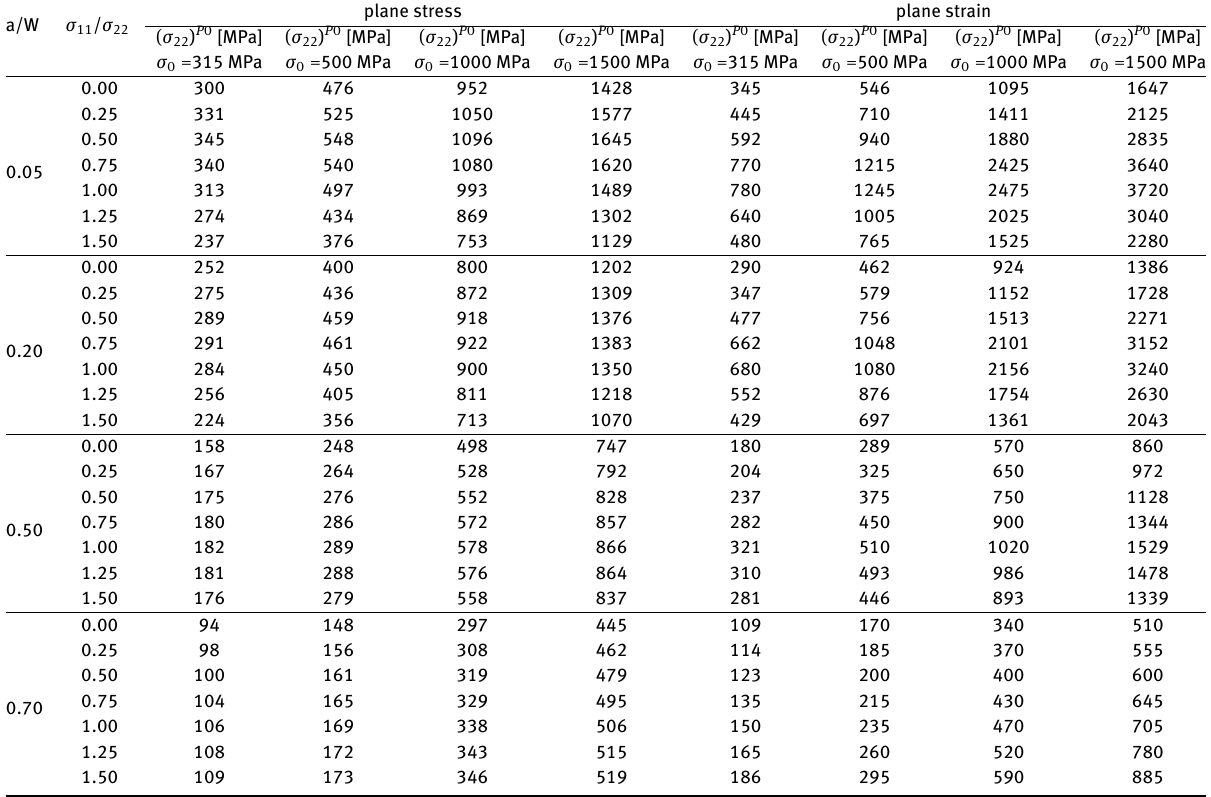
Table 3: Numerically calculated limit loads ( σ 22 ) P 0 for the CCSP(BT) with predominant plane stress or plane strain conditions. plane a/W σ 11 / σ 22